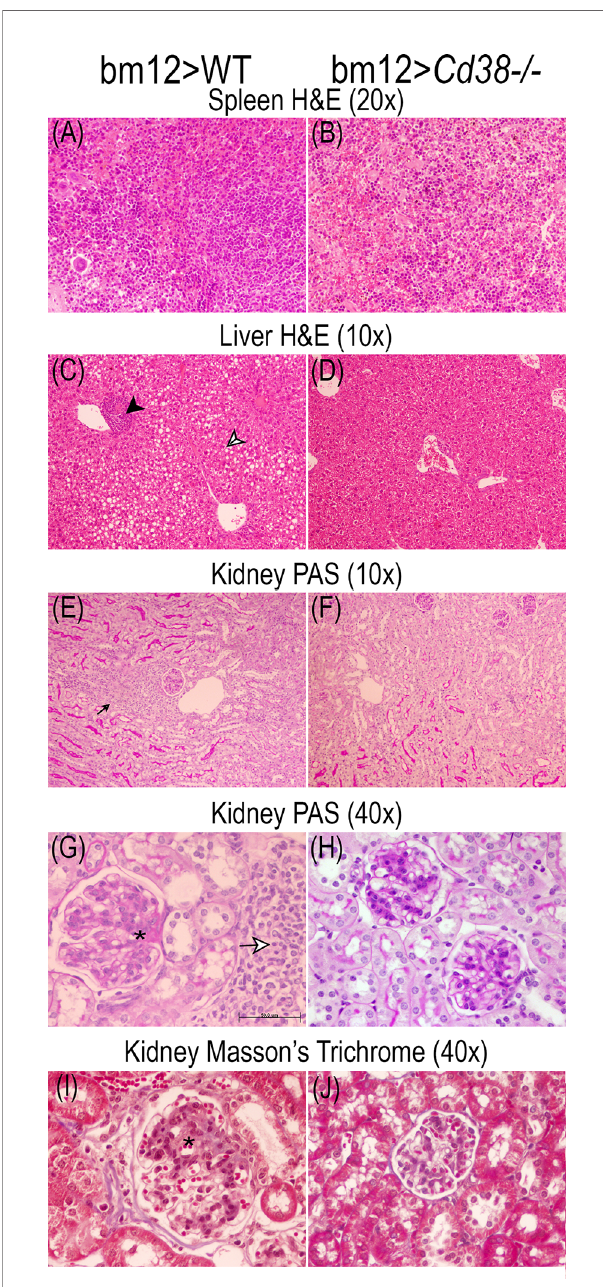
FIGURE 11 | Representative microphotographs of the histological studies performed on the spleen, liver, and kidney 3- m m sections at 8 weeks of the adoptive transfer of spleen cells from female bm12 to female WT (left panels) or Cd38 − / − (right panels) mice. (A, B) Spleen, (C, D) liver, and (E – J) kidney. (A – D) Spleen and liver tissue sections were stained with H&E. (E – H) Kidney tissue sections were stained with PAS. (I, J) Kidney sections were stained with Masson ’ s trichrome. (A, B) ×20 magni fi cation; (C – F) ×10 magni fi cation; (G – J) ×40 magni fi cation. (G) Scale bar: 50 m m. Note in the liver from WT cGVHD mice the presence of mild perivascular chronic in fl ammatory in fi ltrate [black head arrow in (C) ] and macrovesicular steatosis [black and white head arrow in (C) ]. Note in the kidney of WT cGVHD the periglomerular chronic in fl ammatory in fi ltrate [small black arrow in (E) ] and the increased glomerular size [asterisks in (G) and (I)